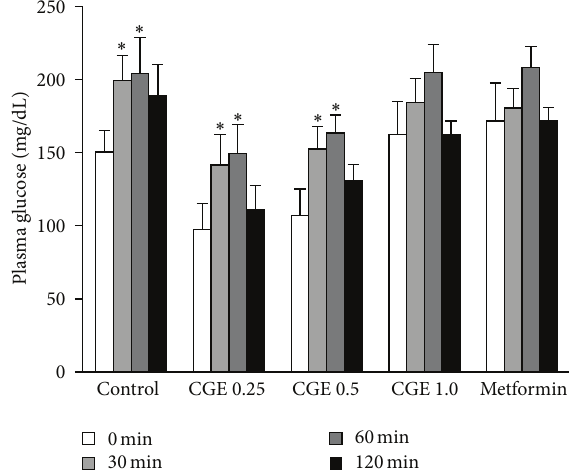
Figure1:Acuteantihyperglycemiceffectof Cladophoraglomerata in normal rats. Oral administration of 0.25, 0.5, and 1g/kg BW of CGE and 20 mg/kg BW of metformin was given to normal rats for 30 min. Subsequently, 50% glucose solution at a concentration of 2 g/kg BW was administered into each rat. Blood samples were individually collected and blood glucose levels were then determined ( 𝑛 = 6–8). ∗ 𝑃 < 0.05 indicates significant differences from blood glucose level before